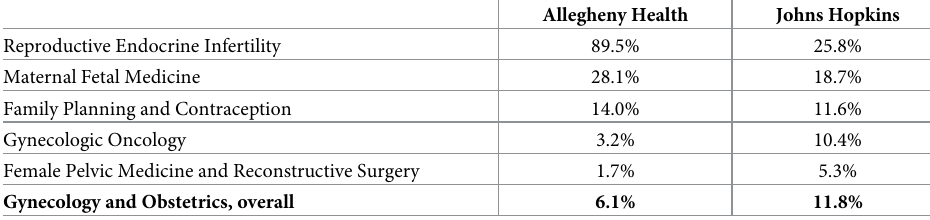
Table 3. Proportion of visits conducted as televisits, by subspecialty and by site (Allegheny Health versus Johns Hopkins) during period 4 (July—December